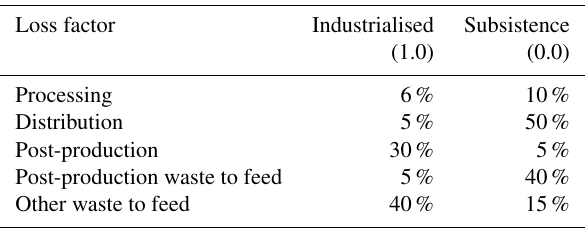
Table 1. Boundary values for factors informed by the food-system efficiency